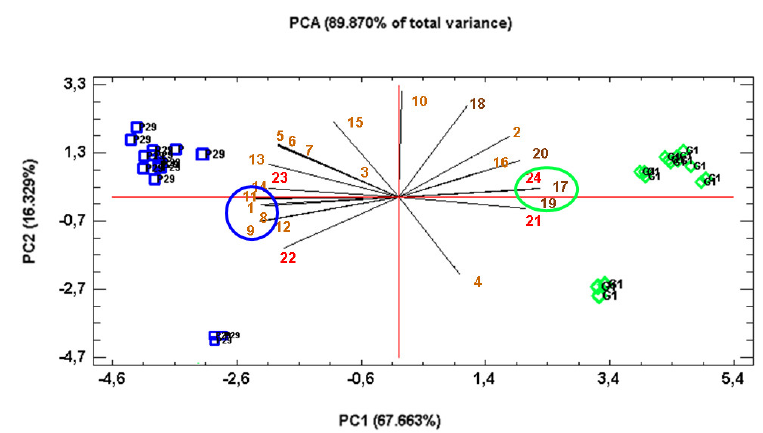
Figure 7. Principal component analysis, PCA. *The different compounds were identified by numbers as follows: 1. Ethyl acetate, 2. Methyl acetate, 3. Ethyl propanoate, 4. Ethyl isobutanoate, 5. Isobutyl acetate, 6. Ethyl 2-methyl butanoate, 7. Ethyl 3-methyl butanoate, 8. Isoamyl acetate, 9. Hexyl acetate, 10. Ethyl heptanoate, 11. Phenylethyl acetate, 12. Ethyl octanoate, 13. Ethyl 2-methyl octanoate, 14. Ethyl decanoate, 15. Ethyl tetradecanoate, 16. Ethyl lactate, 17. Hexanoic acid, 18. Octanoic acid, 19. Tetradecanoic acid, 20. Dodecanoic acid, 21. Eht1p, 22. Eeb1p, 23. Atf1p, 24. Atf2p. The blue color for the P29 strain and green for the G1 strain (flor yeast) were used. Proteins (21–24) were represented in red, fatty acid esters (1–16) in dark yellow and fatty acids (17–20) in dark brown.